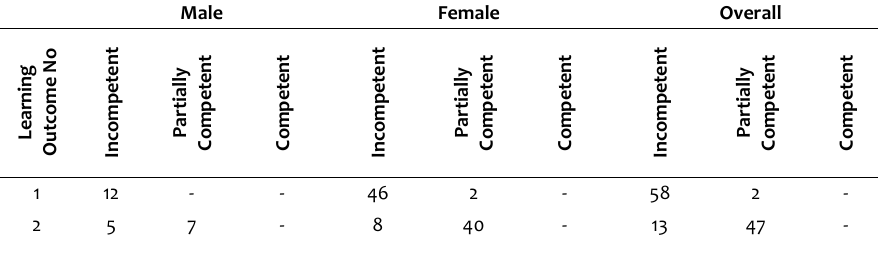
Table 3. The pre-service teachers’ competence in associating the learning outcomes included in the curriculum with